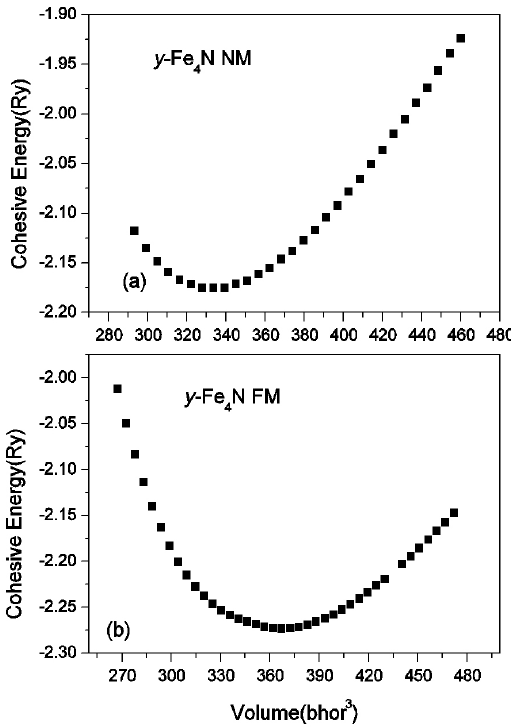
Figure 4. Cohesive energy depending on the volume of nitride N in ferromagnetic and non-magnetic phases. γ – Fe 4